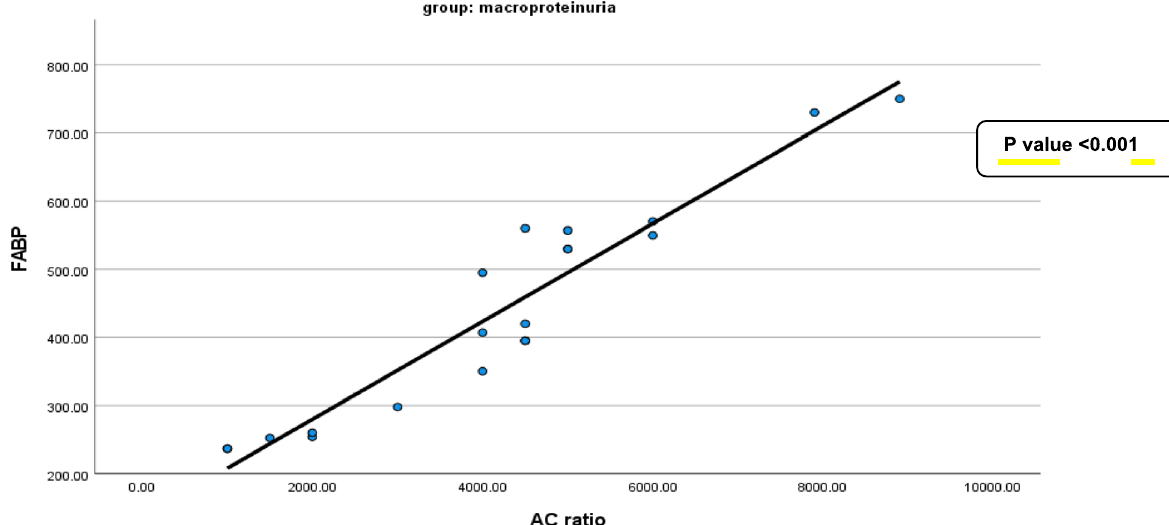
Fig. 2 Correlation between serum FABP4 and albuminuria in the macroalbuminuria